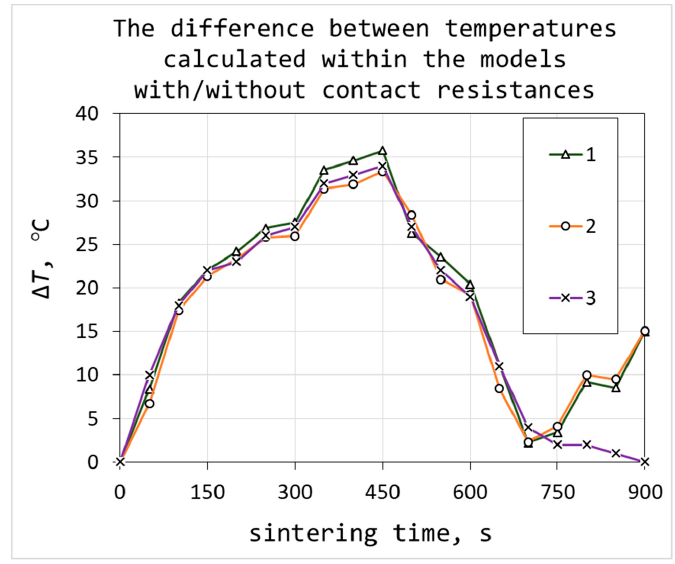
Figure 9. The difference between maximum sintering temperatures (1), minimum temperatures (2) and temperatures in the thermocouple (3) obtained from the models with and without contact resistances.